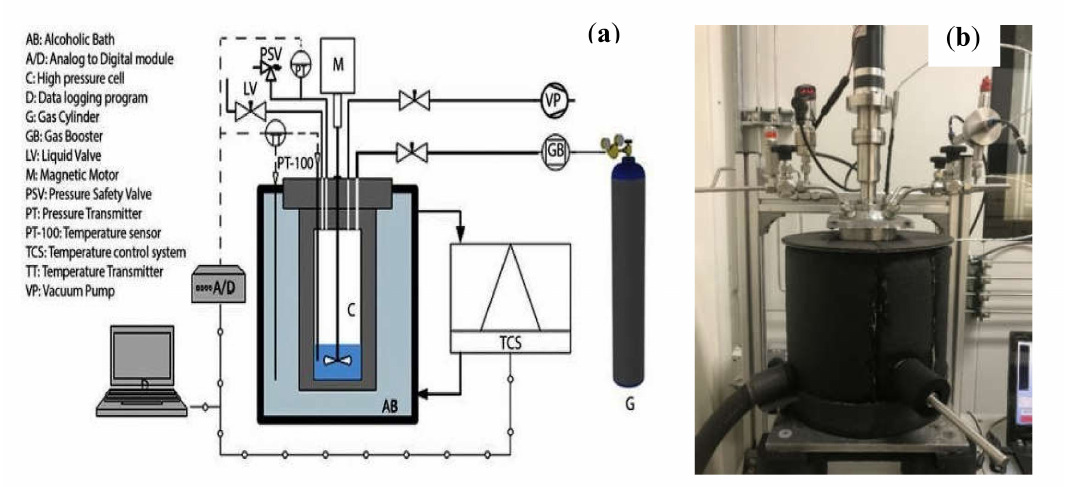
Figure 5. Experimental set-up used in this study: ( a ) schematic; ( b ) Image of the actual setup.